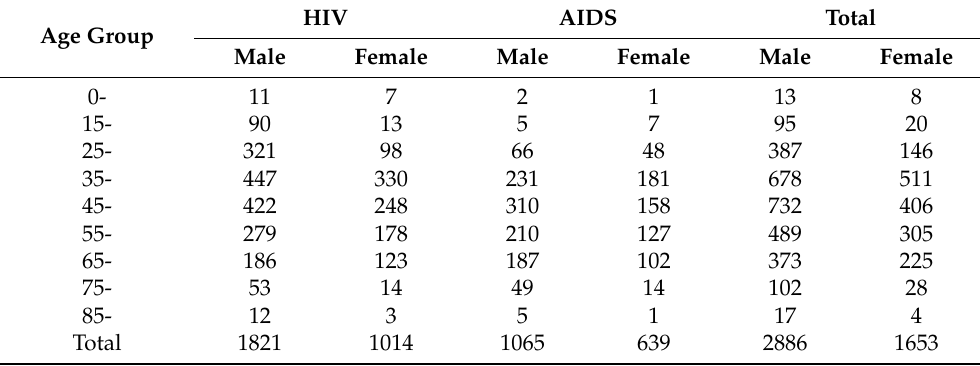
Table A1. Age and gender distribution of people living with HIV in Guangxi Province.